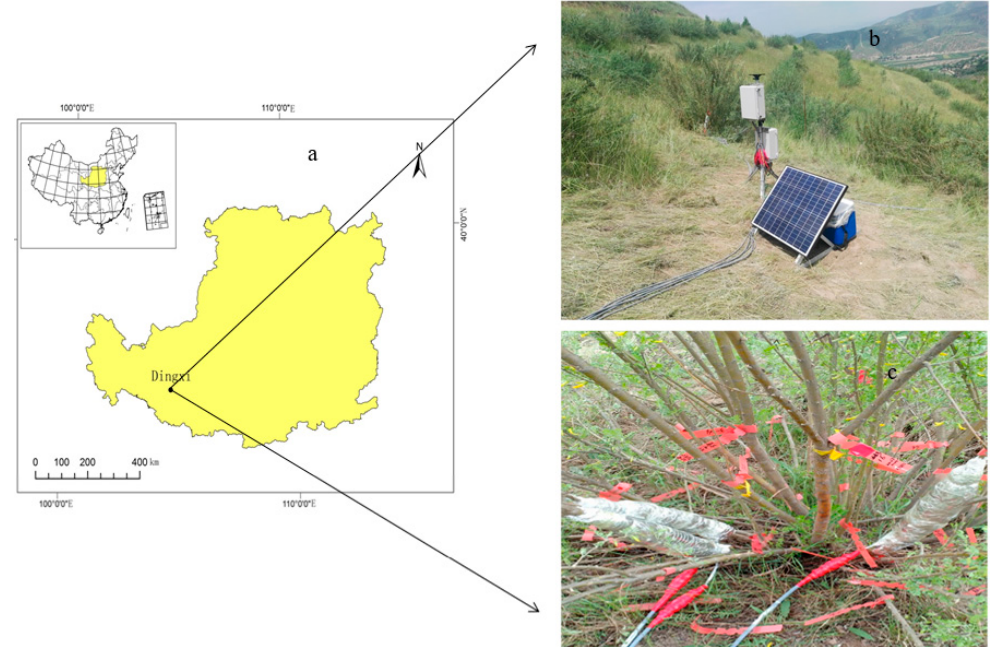
Figure 1. Location of the study area ( a ) and photos of the devices used to measure sap flow in the stems ( b , c ).